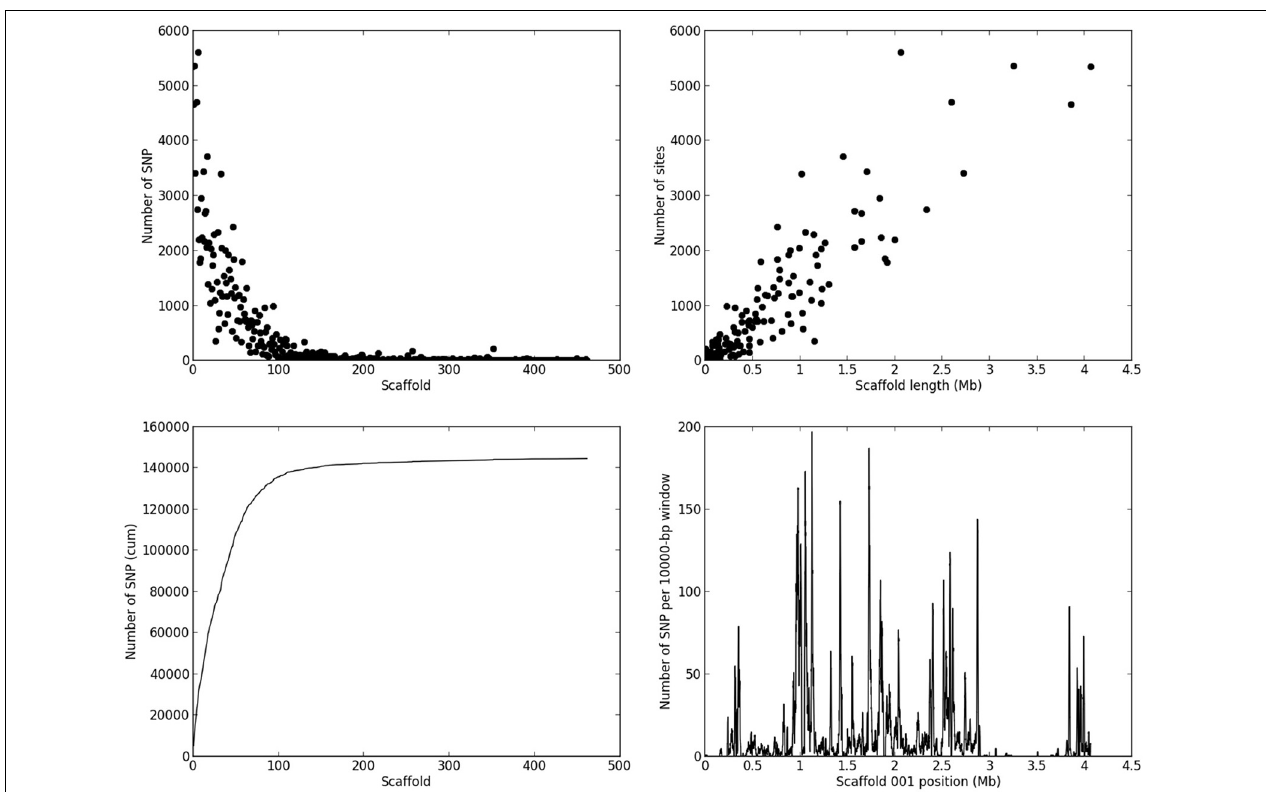
FIGURE 3 | Distribution of SNPs across the M. larici-populina genome. The figure presents the number of SNPs detected per scaffold (upper-left panel, the scaffold are sorted by decreasing length in the genome assembly),